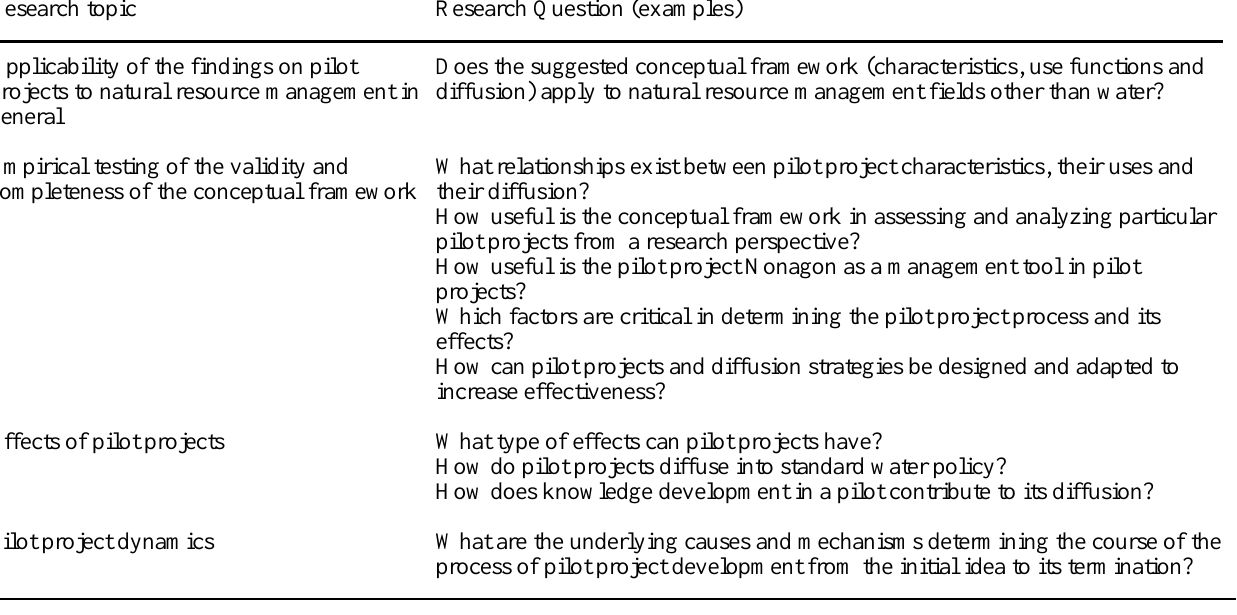
Table 3 . Research agenda for pilot projects Research